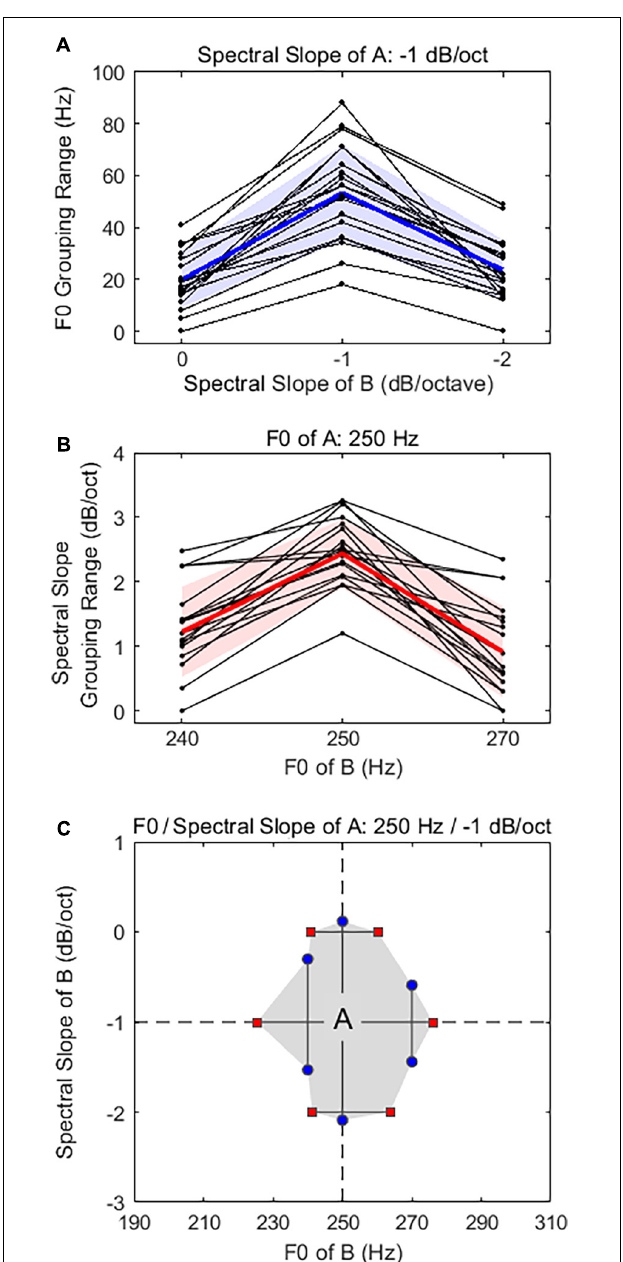
FIGURE 3 | Individual and average F0 grouping range results (A) and spectral slope grouping range results (B) . In each panel, the solid thick line with the shaded area indicates the mean with standard deviation for all subjects, and thin solid lines show individual data. (C) Two-dimensional representation of auditory grouping ranges. The intersection of two dashed lines indicates the F0 and spectral slope of the stimulus A. Shaded region shows “grouping area” which are demarcated by upper and lower boundaries of the grouping ranges in F0 and spectral slope domains.